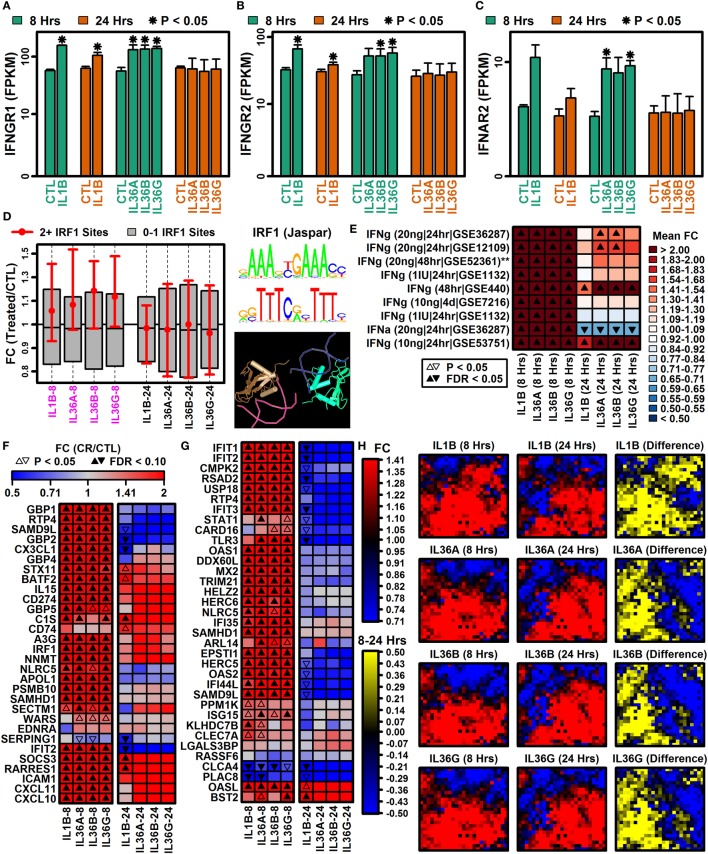
Type I and II interferon genes have time-dependent IL-1B and IL-36 responses. (A) Interferon gamma receptor 1 (IFNGR1). (B) Interferon gamma receptor 2 (IFNGR2). (C) Interferon alpha and beta receptor subunit 2 (IFNAR2). In panels (A–C), average FPKM (±1 SE) is shown for each group, and asterisks denote significant differences relative to the control (CTL) treatment at the corresponding time point (paired two-sample t-test; n = 2 or 3 per treatment). (D) Genes with interferon response factor 1 (IRF1) binding sites (5 kb upstream region). The middle 50% of FC estimates is shown for genes with 2+ IRF1 binding sites compared with genes with fewer IRF1 sites (magenta font, horizontal axis: P < 0.05, Wilcoxon rank sum test). The IRF1 position weight matrix is shown (right) along with the IRF1 tetrameric structure (bottom right; NCBI structure database). (E) IFN-induced gene signature scores. IFN-induced genes were identified from microarray studies of IFN-treated keratinocytes (left margin), and the average FC for these genes was calculated in IL-1B/IL-36 experiments (bottom margin). Left margin labels indicate the cytokine concentration (in ml), treatment duration, and GEO series accession number. All cytokine experiments were replicated with at least two samples per treatment. (F) Top 30 IFN-g-induced genes (identified from GSE36287). (G) Top 35 INFa-induced genes (identified from GSE36287). (H) Self-organizing maps (SOMs). The SOM layout was determined only from IFN-g-induced genes (i.e., 2,500 genes most strongly induced by IFN-g, GSE36287). Colors reflect average FC estimates for IFN-g-induced genes assigned to each SOM region (columns 1 and 2 on left). The final column (yellow–blue) displays the mean FC difference for each cytokine with respect to each SOM region (8 h mean FC–24 h mean FC; log2 scale).